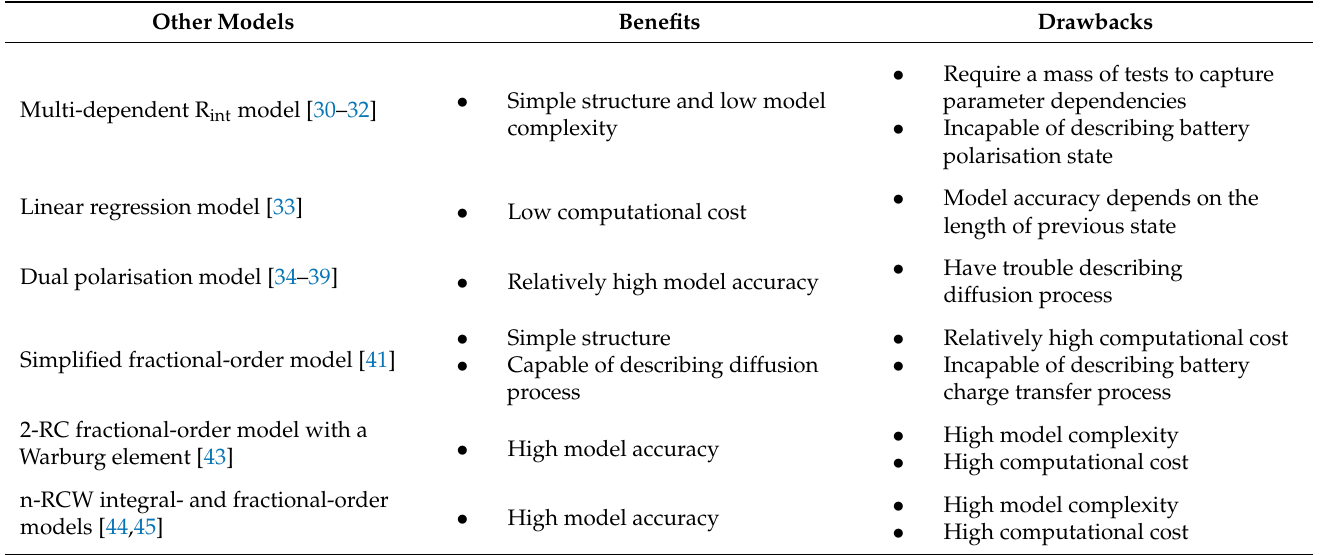
Table 2. Benefits and drawbacks of other models with different structures from 1-RC model and its variants in online SOP